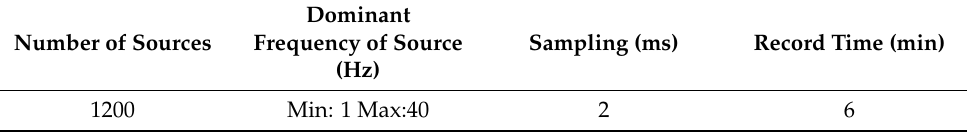
Table 3. Numerical parameters of the microtremor survey numerical simulation.